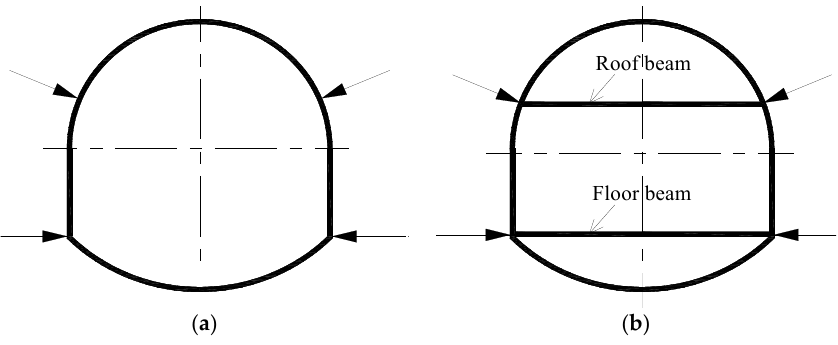
Figure 2. Loads applied on steel set: ( a ) direct loads on steel set; ( b ) extra beams on steel set.